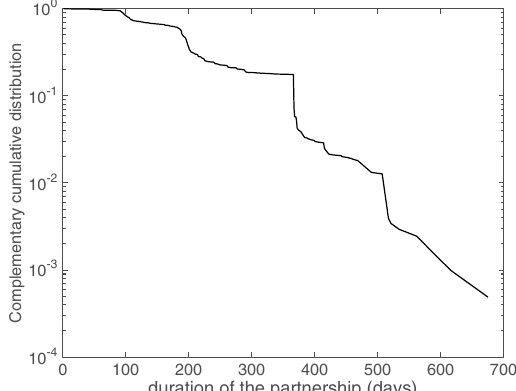
Figure 2. Complementary cumulative distribution of the duration of the partnerships. The roughly linear tail of the distribution indicates an exponential distribution of the highest durations.